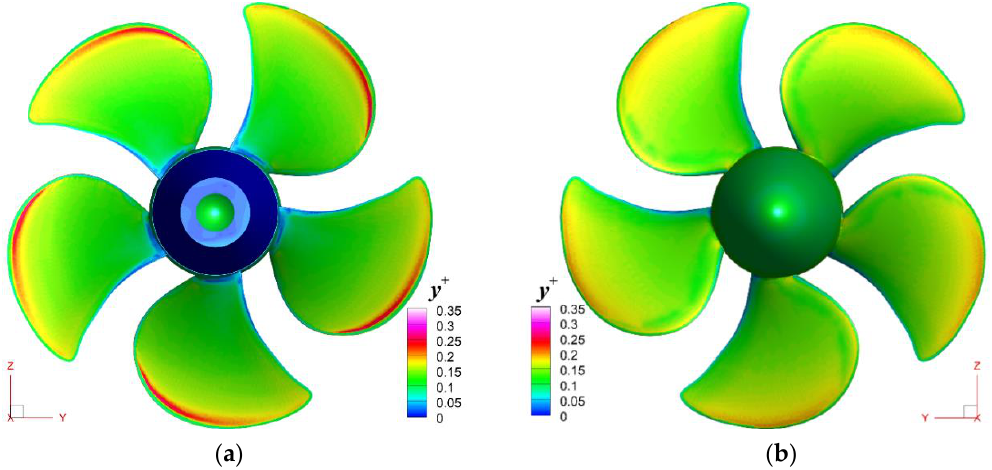
Figure 6. y + distribution on the propeller blades computed at J = 0.6418. ( a ): pressure side; Figure 6. 𝑦 + distribution on the propeller blades computed at 𝐽 = 0.6418 . ( a ): pressure side; ( b ): ( b ): suction suction side.